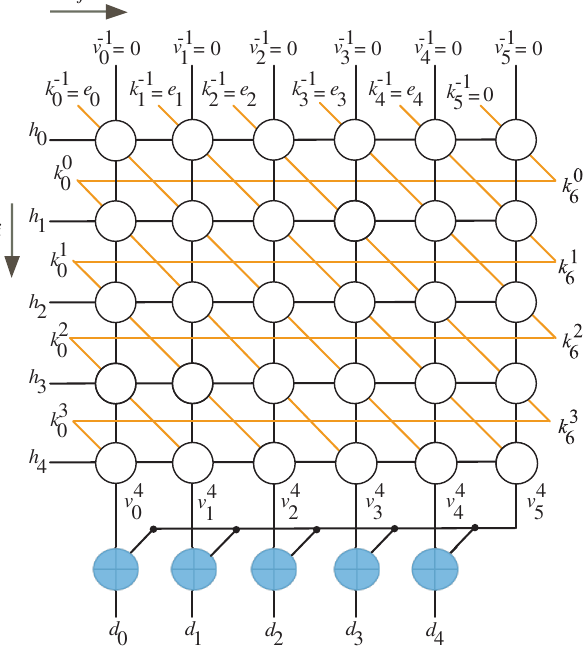
Figure 1. DG of the recommended multiplication algorithm for n =